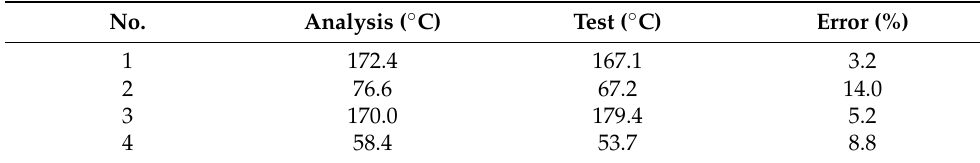
Table 2. Comparison of temperature measurement results.